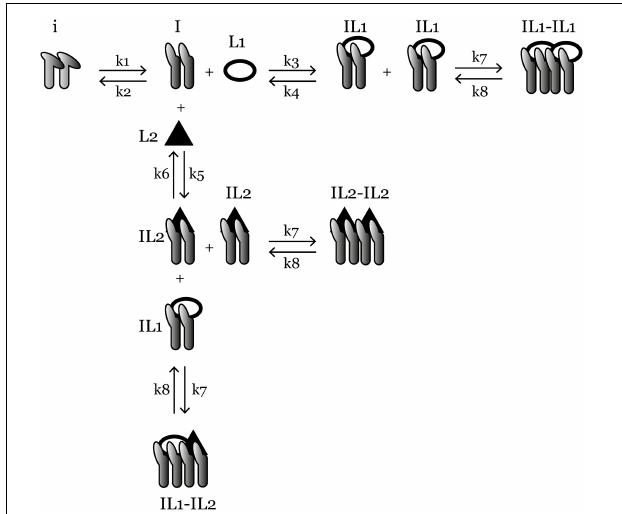
FIGURE 1 | An overview of the ligand-competition model reactions. i is the inactive integrin, I is activated integrin, IL 1 is L 1-bound integrin, IL 2 is